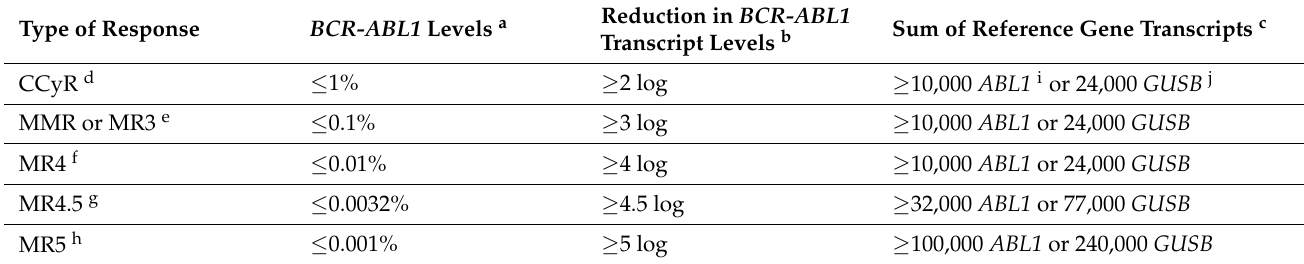
Table 2. Scoring molecular response.